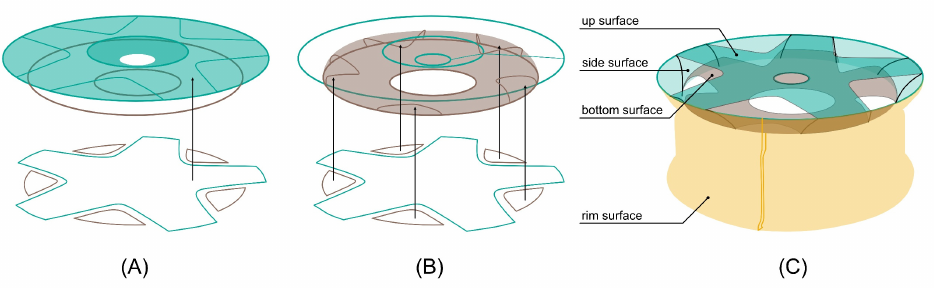
Figure 9. 3D model building process. ( A ) Projection on the upper surface. ( B ) Projection on the bottom surface. ( C ) Combining the surfaces to form the complete shape of the wheel hub.